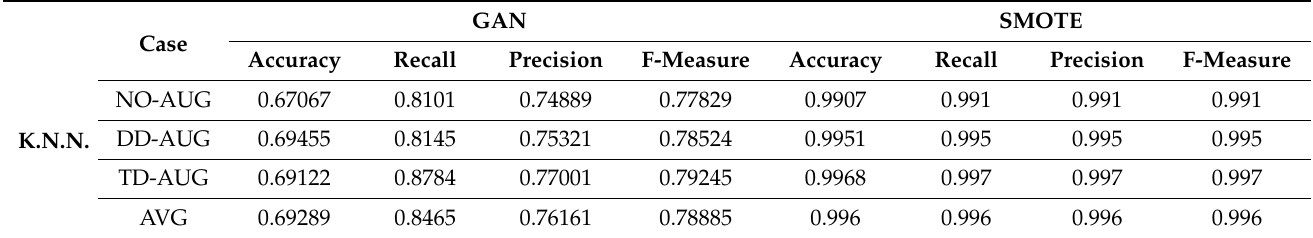
Table 4. Evaluation of kNN Classifier for NO-AUG, DD-AUG and TD-AUG.